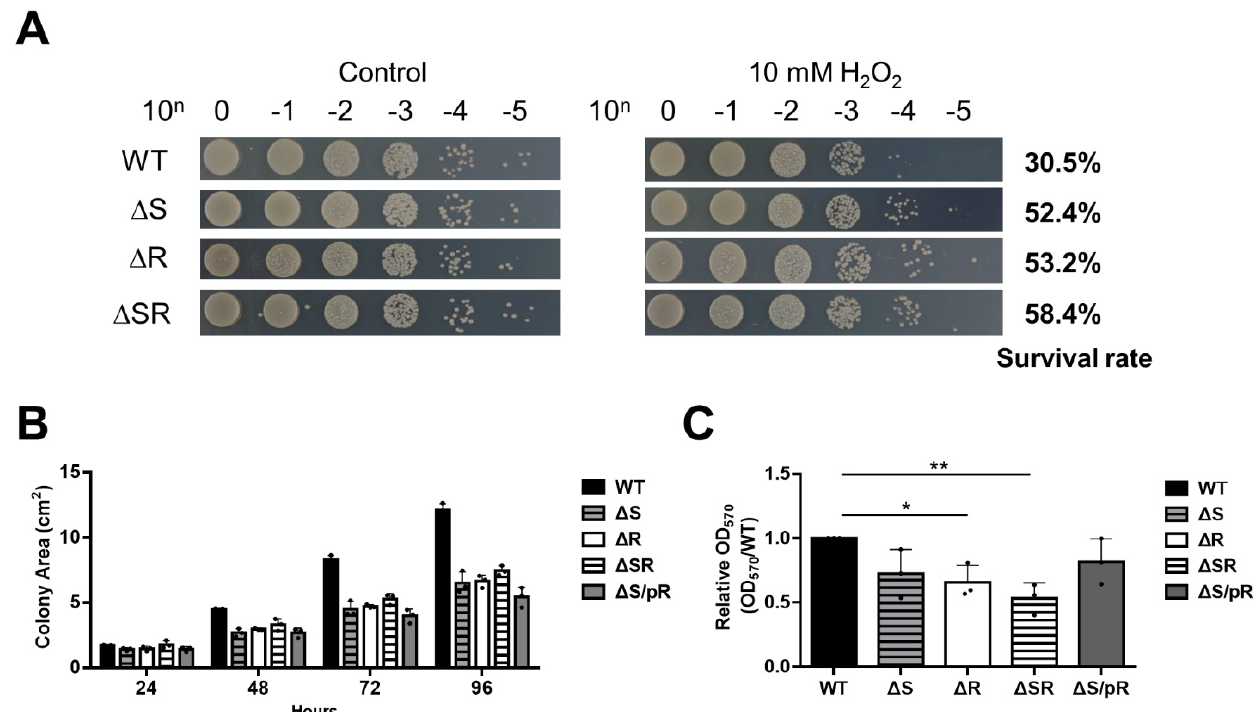
Figure 4. Oxidative resistance, motility, and biofilm formation capabilities in EmaSR mutant strains. ( A ) Inorganic oxidative resistance assay results. Bacteria were cultured until OD 600 of 0.6, and treated with 10 mM H 2 O 2 for 20 minutes. Five µ L each of bacteria were dropped onto LB agar plates to determine the survival rate. ( B ) Motility assay results. Each strain was cultured in 0.25% LB agar for 72 hours. Swimming areas evaluated in triplicate for each strain was determined using ImageJ at the time points indicated. ( C ) Quantification of biofilm formation in polystyrene 96-well plates. Relative OD 570 was determined after crystal violet staining. Experiments were performed in triplicate. * p < 0.05; ** p < 0.01.